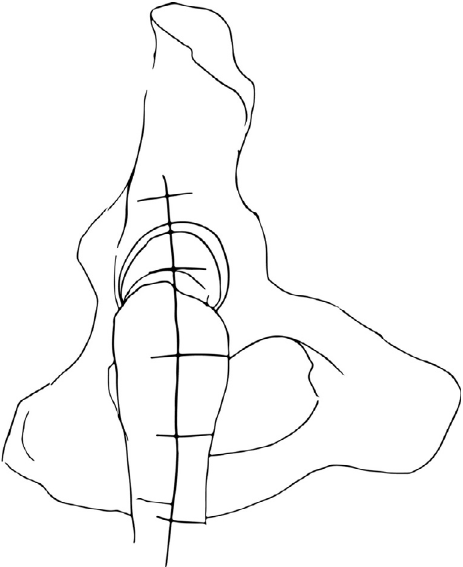
Figure 2. Skin incision